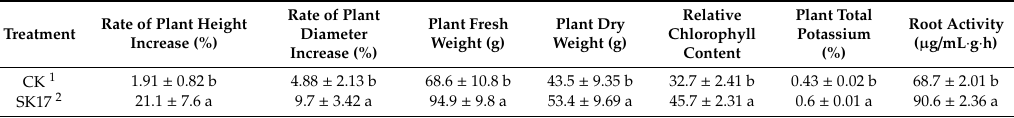
Table 1. E ff ect of Bacillus. aryabhattai SK1-7 at 100 days after inoculation on the growth indexes of P. alba . Di ff erent letters above the bars indicate significant di ff erences ( p < 0.05). Treatment